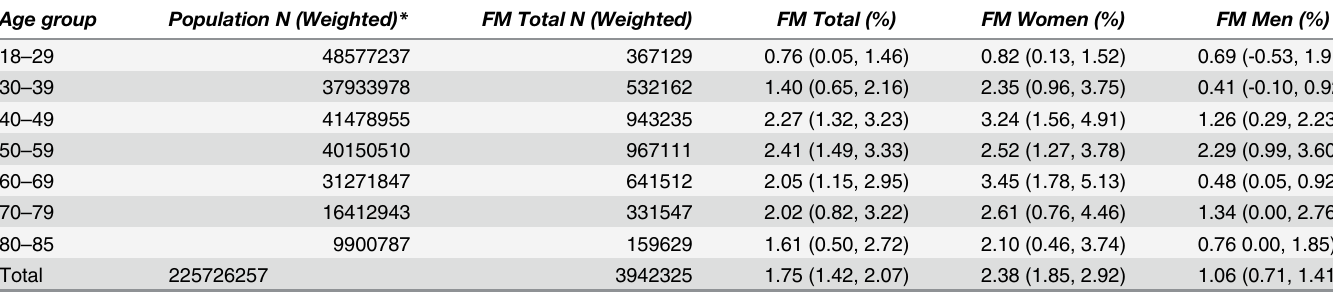
Table 1. Prevalence of fibromyalgia in adult general population